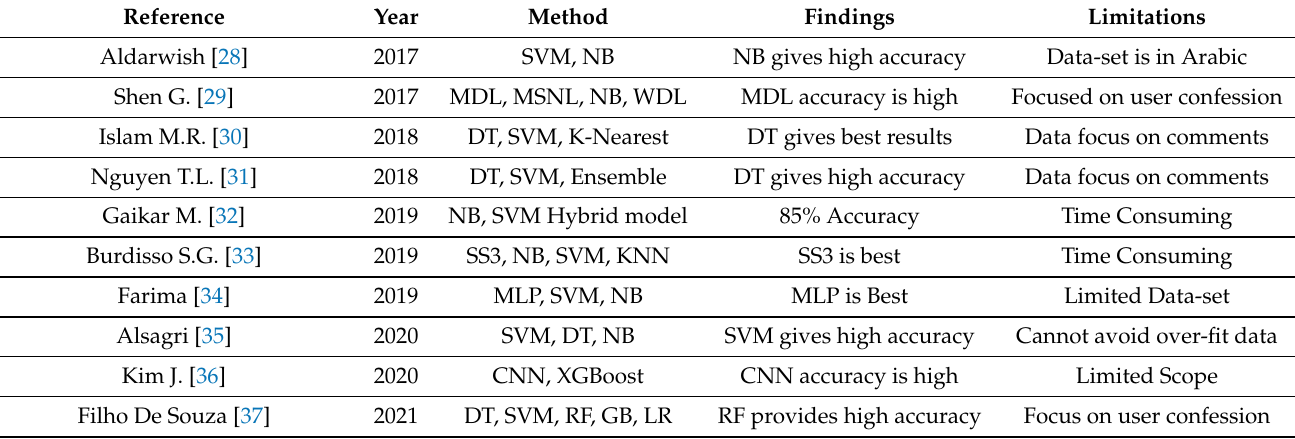
Table 1. Summary of Related Works from 2017 to 2021. Keys: NB—Naive Bayes, SVM—Support Vec- tor Machine, LR—Linear Regression, DT—Decision Tree, RF—Random Forest, CNN—Convolutional Neural Network, MLP—Multi-Layer Perceptron, MDL—Minimum Description Length, MSNL— Multiple Social Network Learning, WDL—Weighted Deep learning, GB—Gradient Boosting, SS3—a text classification